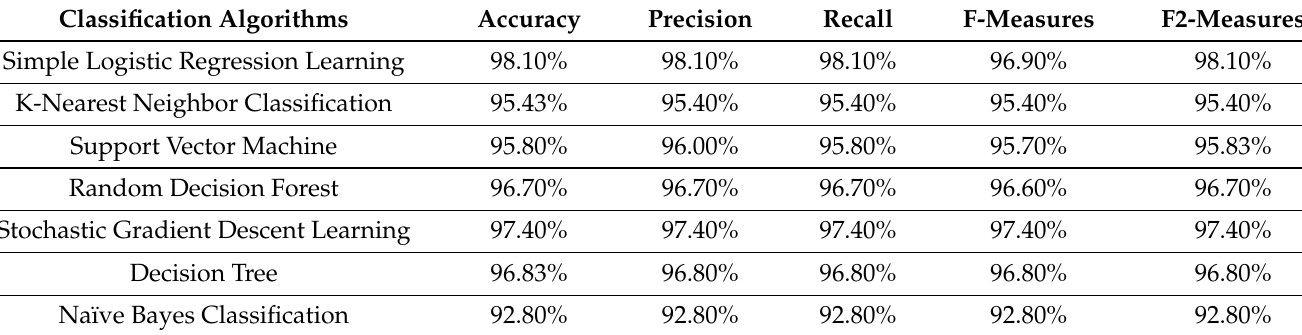
Table 4. Comparison of the performances of different classification methods for WBCD after applying the wrapper feature selection method.